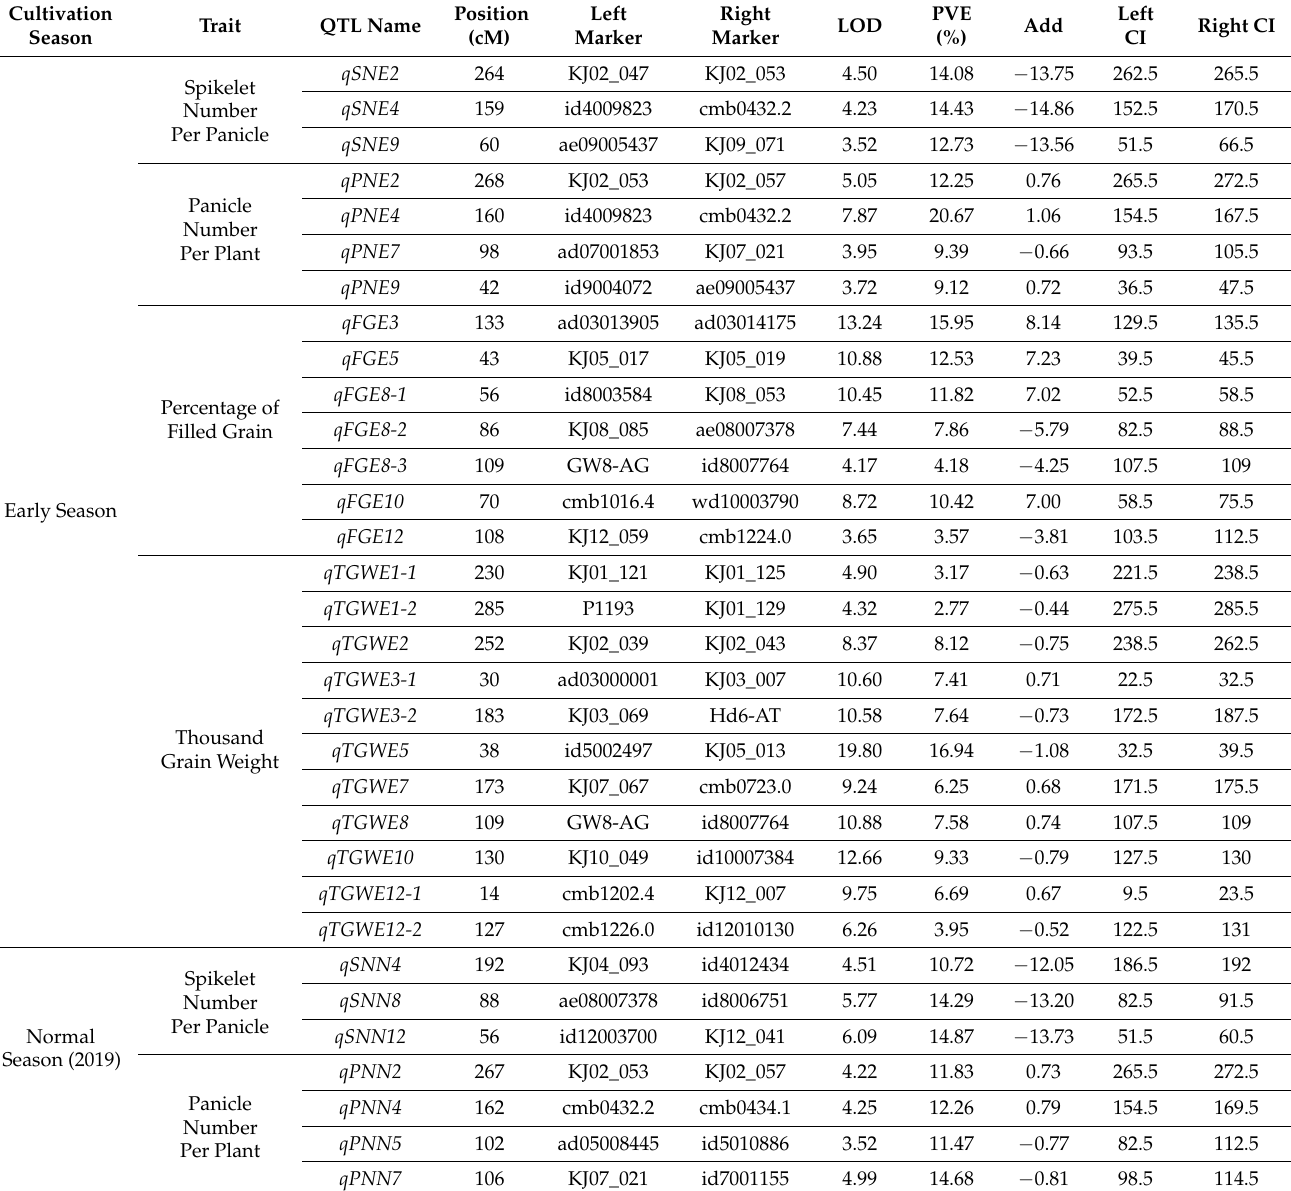
and Figure 2, a total of 56 QTLs were detected (all years and cropping seasons considered). Of this number, thirteen QTLs (seven under early cropping, four under normal cropping, and two under late cropping seasons of (Korean conditions) associated with grain filling (hereinafter referred to as FG) in rice were identified and mapped on five chromosomes in the present populations (Chr 3, 5, 8, 10, and 12). The qFGL5-2 , detected in the DH population grown under late cropping season, mapped on Chr 5, had the highest logarithm of the odds (LOD) value of 15.16 and a phenotypic variation explained (PVE) of 21.66%. Other significant QTLs, qFGE3 , qFGE8-1 and qFGE10 , recorded LOD and PVE values of 13.24 and 15.95%, 10.45 and 11.82%, and 8.72 and 10.42%, respectively. The findings of the GxE analysis on FG indicate that the early season of 2018 and normal season of 2019 exhibited congruent characteristics. Consequently, it is possible to discern qFG3 , which encompasses qFGE3 and qFGN3 , within a particular environmental setting (Figure 3 and Table S4). Table 3. Detected quantitative traits loci in different